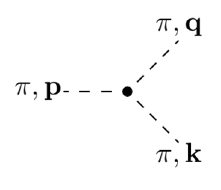
Figure 4 . The Feynman diagram and notation for the phonon decay